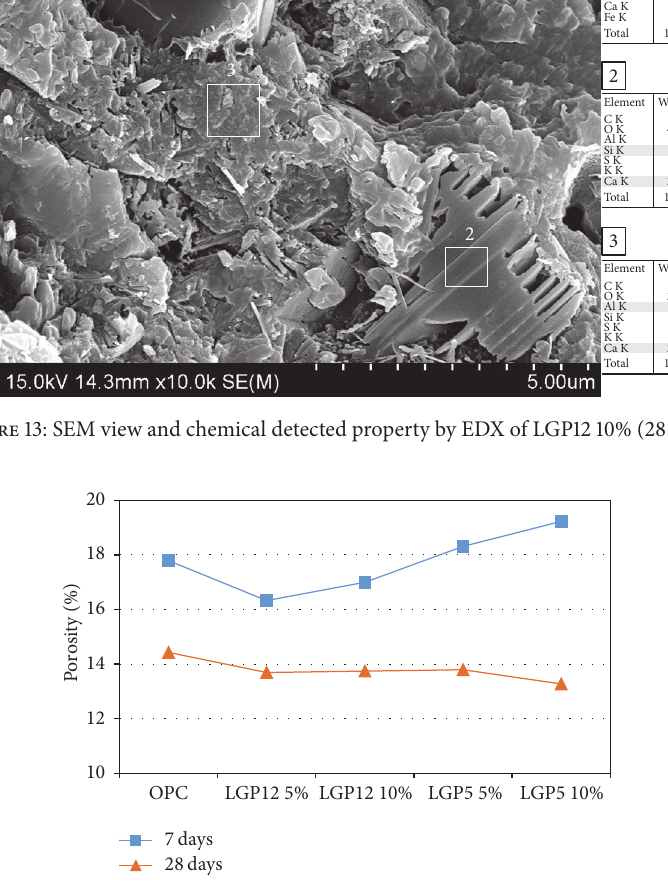
Figure 14: Porosity characteristics of concrete with